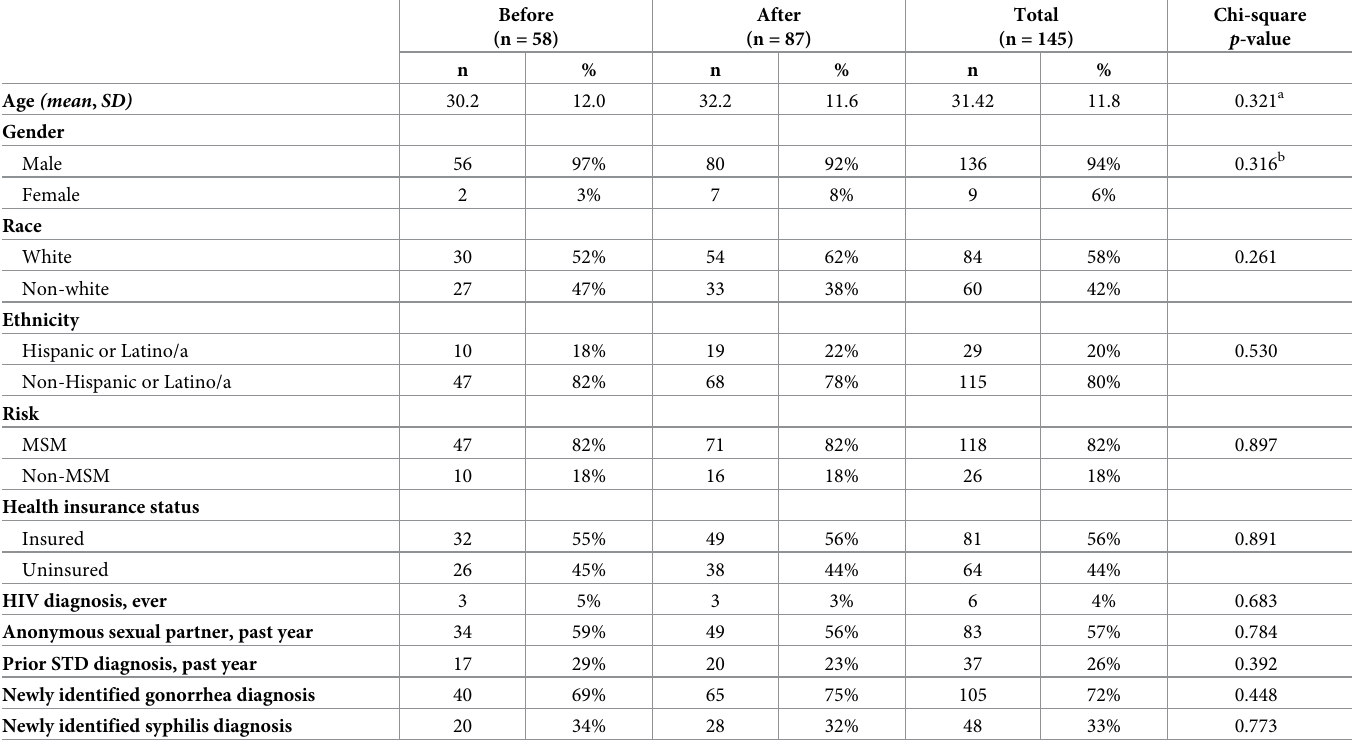
Table 1. Characteristics of index patients before and after implementation of an on-site DIS at an STD